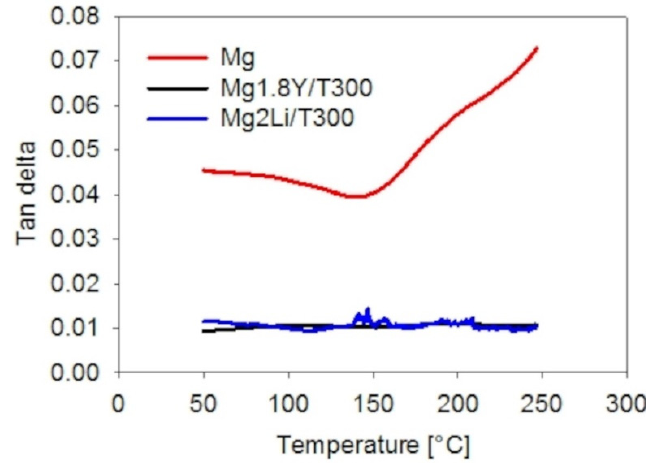
Figure 16. Damping capacity values of the composites with T300